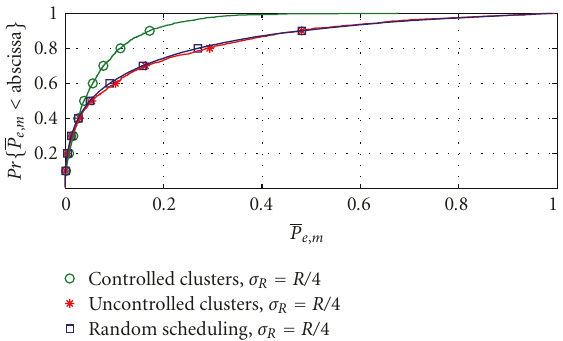
Figure 7: CDF of P e , m when scheduling a subset of clusters.